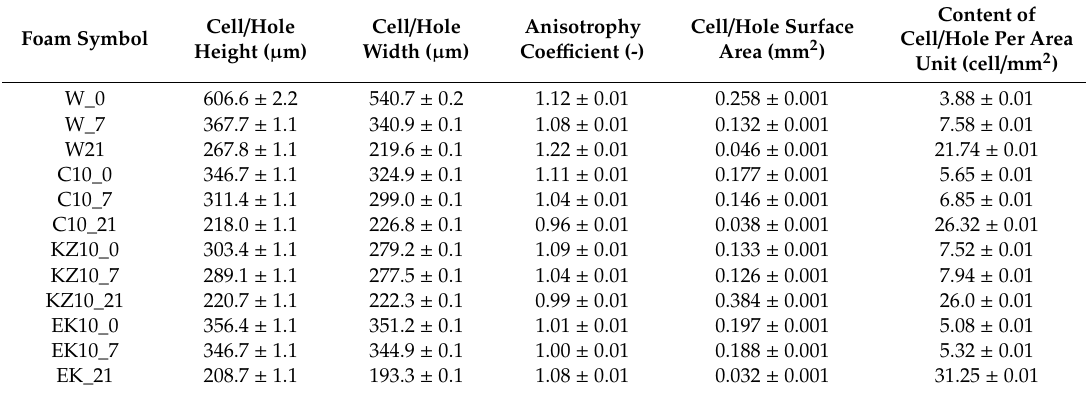
Table 8. Results of SEM micrographs analysis.